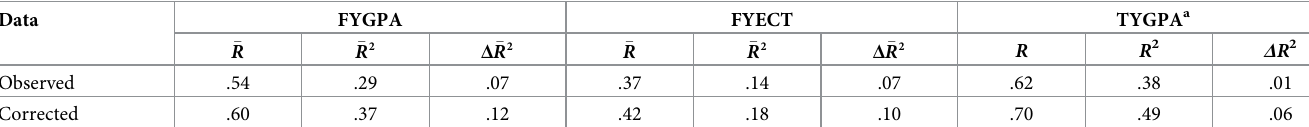
Table 3. Incremental validity of the literature-based curriculum-sampling test over high school GPA.